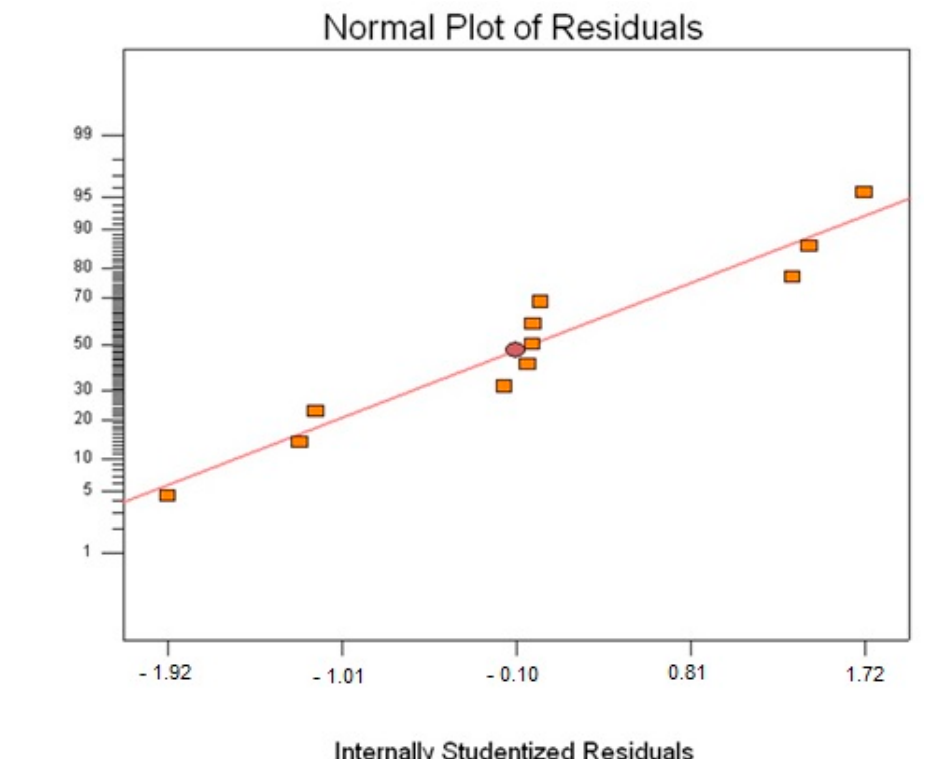
Figure 11. Normal probability plot of residual for T g data (rectangular plots are the 11 points in the CCD).